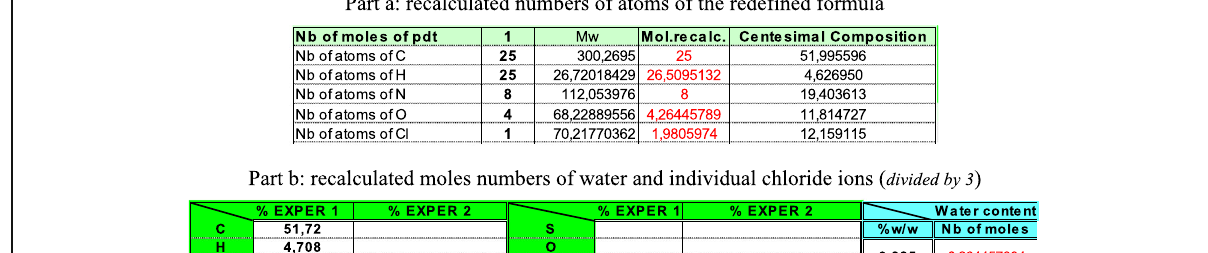
The titration of the drug substance in this sample can be now calculated based on the ratio of the molecular weight of the non-salified substance to the weight of the refined raw formula described above: 536 : 973 (cid:2) 100 (expressed on the dried and 585 : 359 non-salified substance).